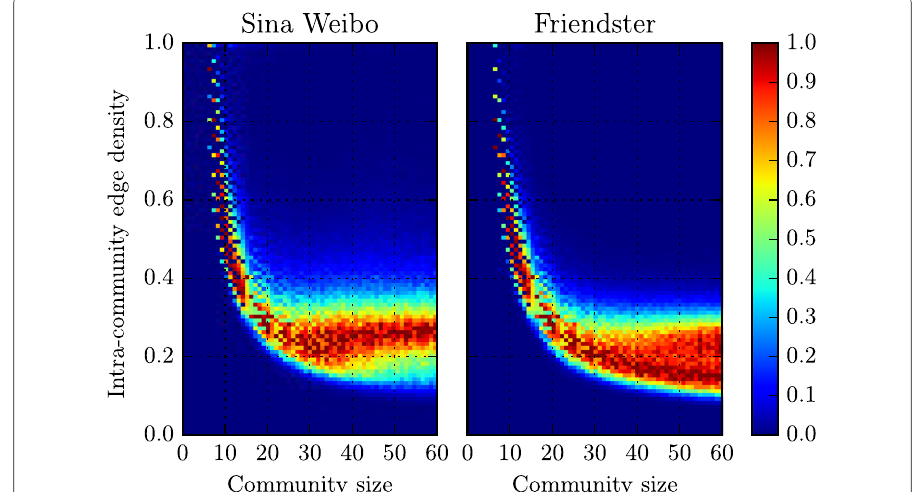
Fig. 9 Histograms of the detected communities grouped by their size and intra-community edge density. The value, as given by the color, in each vertical cut are rescaled by mapping the highest value to